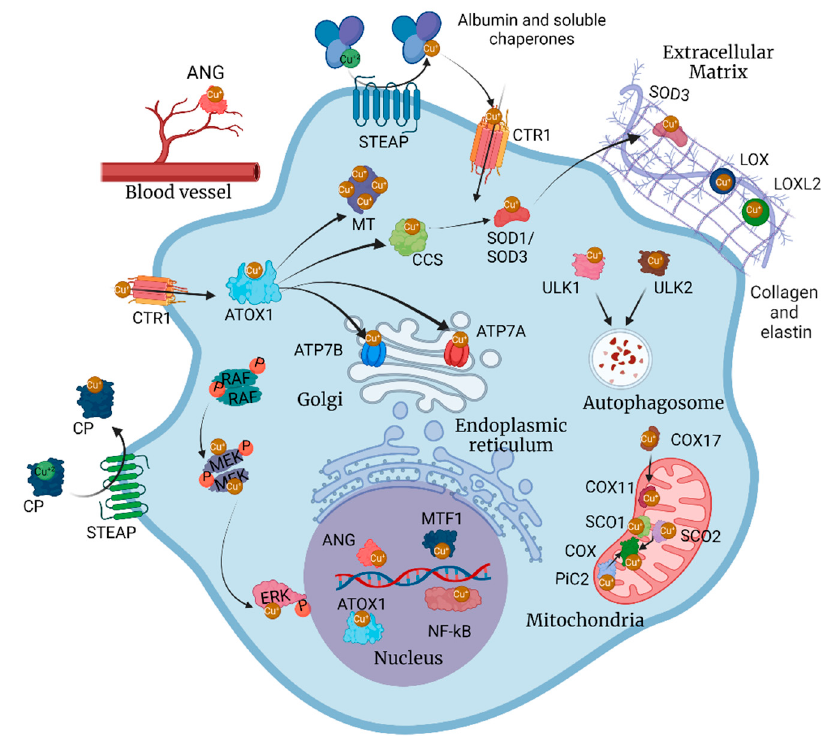
Figure 1. The copper (Cu) network in cancer. Carcinogenic cellular pathways like cell proliferation, survival, migration, invasion, metastasis, and drug resistance are enhanced by Cu bioavailability. Cu-responsive molecules are involved in cell cycle, angiogenesis, remodeling of the extracellular matrix, and autophagy. Figure created with BioRender.com (accessed October 2022).